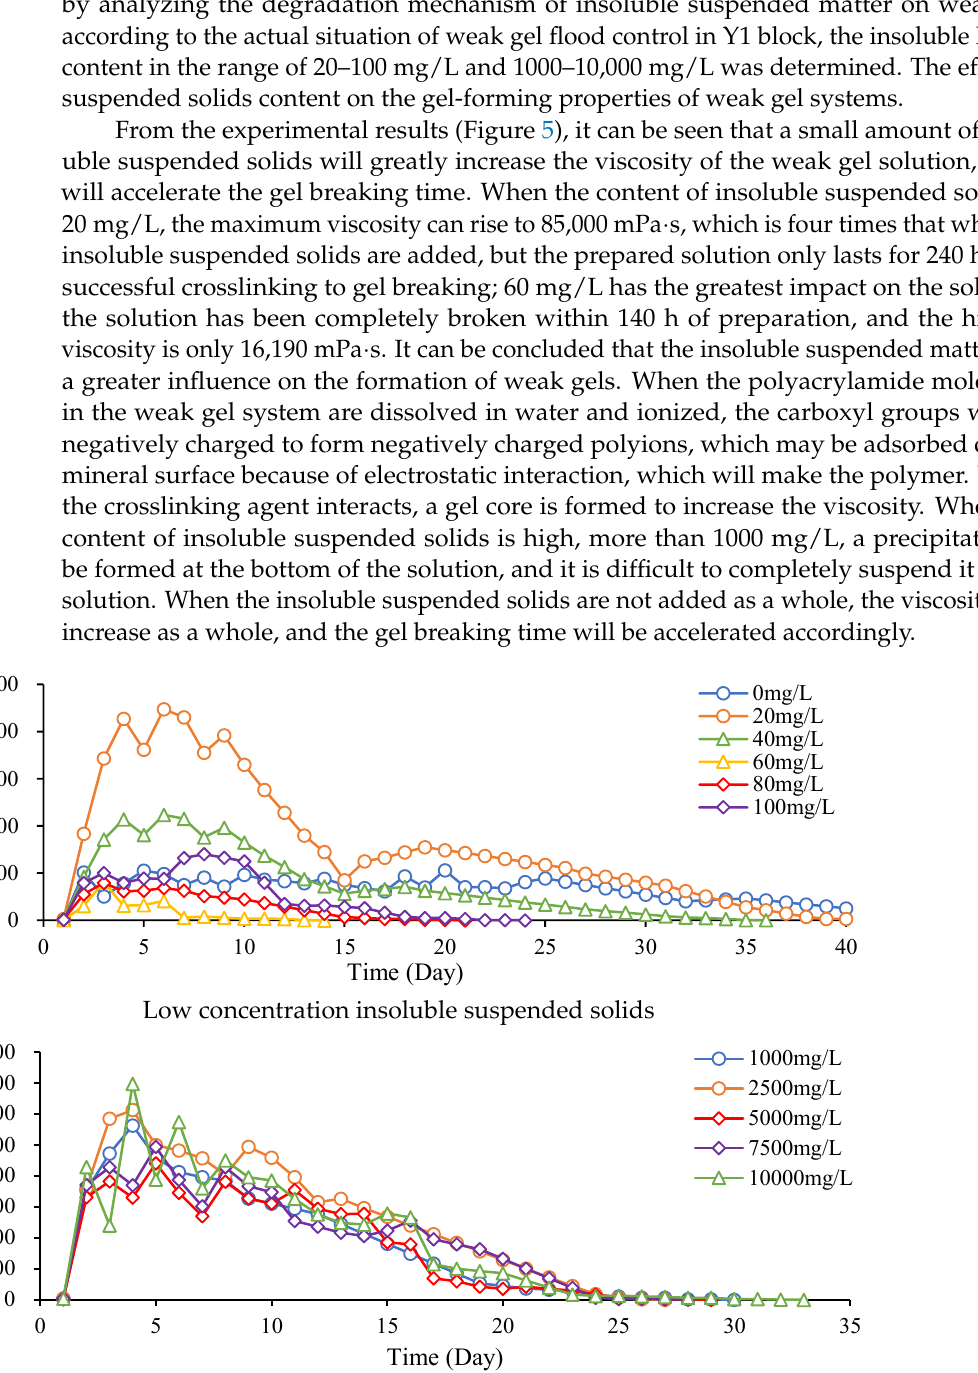
Figure 4. The effect of bacterial content on the gelation of weak gels.